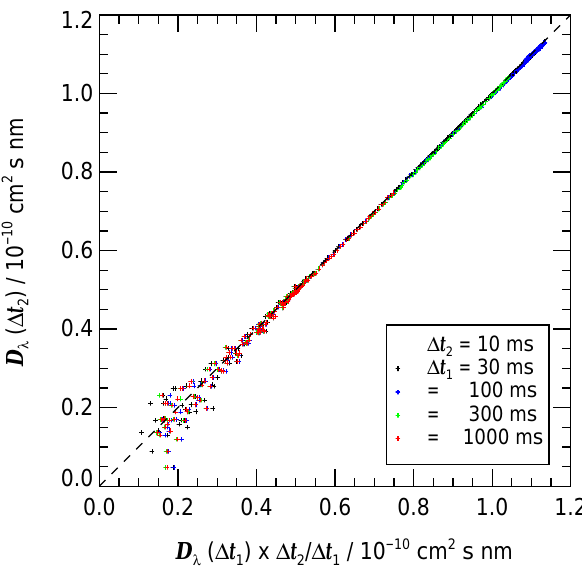
Figure 7. Comparison of spectral sensitivities of instrument 62001 for an integration time of 10ms ( (cid:49)t 2 ) with scaled spectral sensitiv- ities obtained at other integration times ( (cid:49)t 1 ). Scaling factors were calculated according to Eq. (13). Data points cover all wavelengths. The dashed line indicates perfect